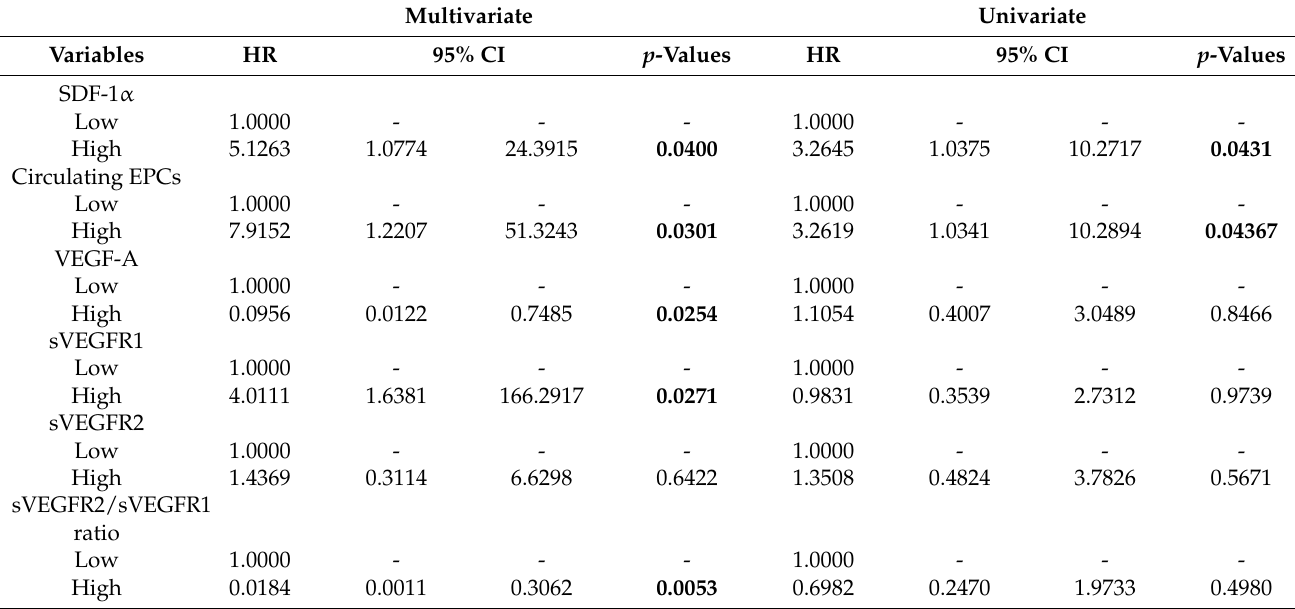
Table 3. The multivariate and univariate Cox regression models for disease-free survival (R 2 = 0.9220). Multivariate Univariate